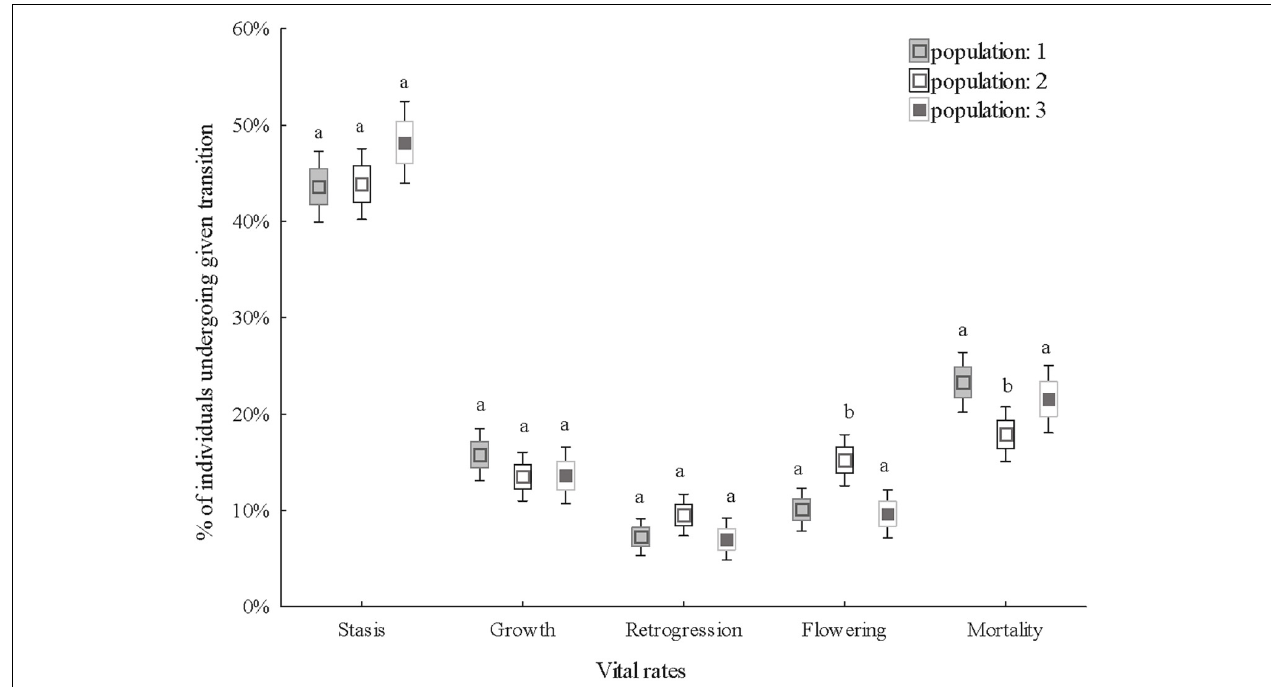
FIGURE 2 | Comparison of the vital rates of three populations. The vital rates are the probability of stasis (survival and remaining in the same stage), growth (growth to a larger stage), retrogression (shrinkage from a large to a small stage), flowering and mortality the following year. Boxes show means, standard errors and 1.96 * standard errors (defining 95% confidence interval of the mean) of the percentage of individuals undergoing a given transition. Different letters indicate significant differences in vital rates between populations (Tukey’s post hoc test, P < 0.05).